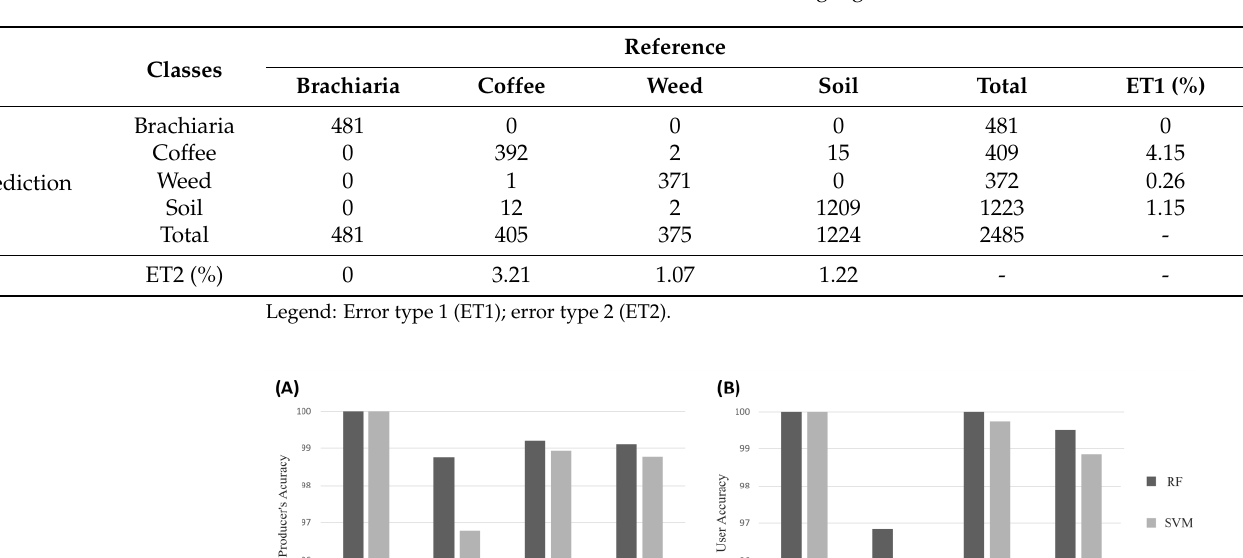
Table 3. Confusion matrix for the SVM machine learning algorithm.